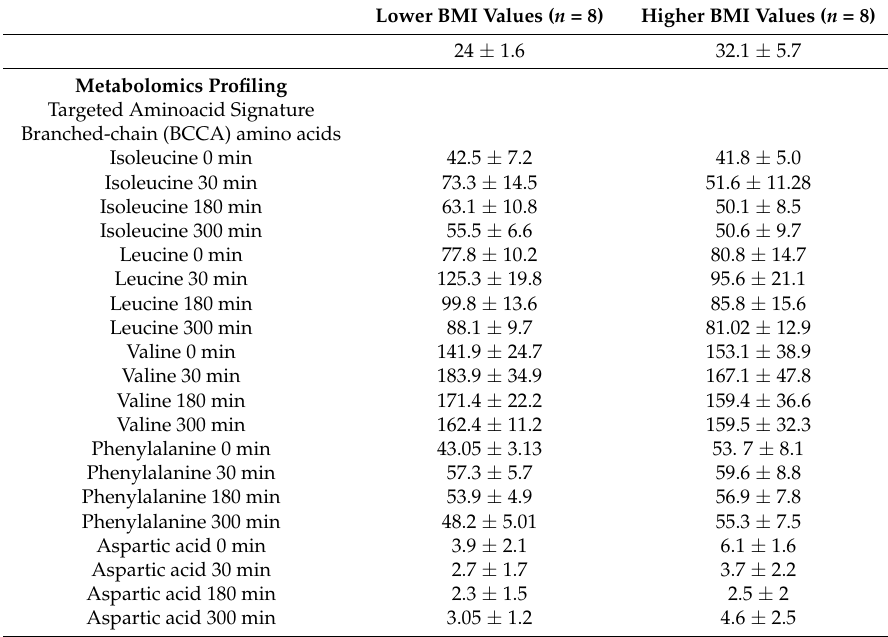
Table 3. Fasting and postprandial phenotypes related to metabolomics, amino acid signatures and